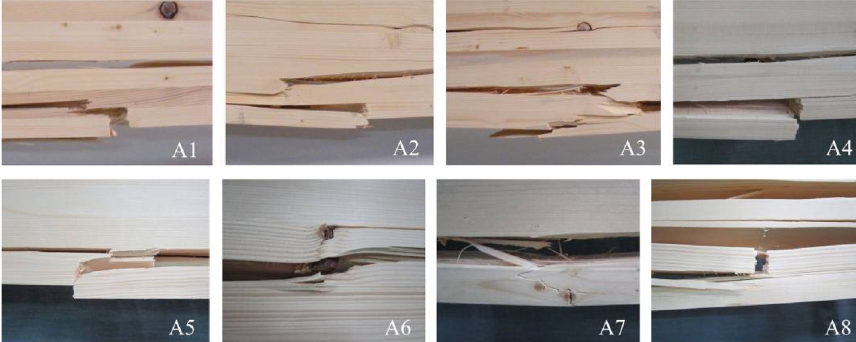
Fig. 1. Failure mechanism of Series A unreinforced beams